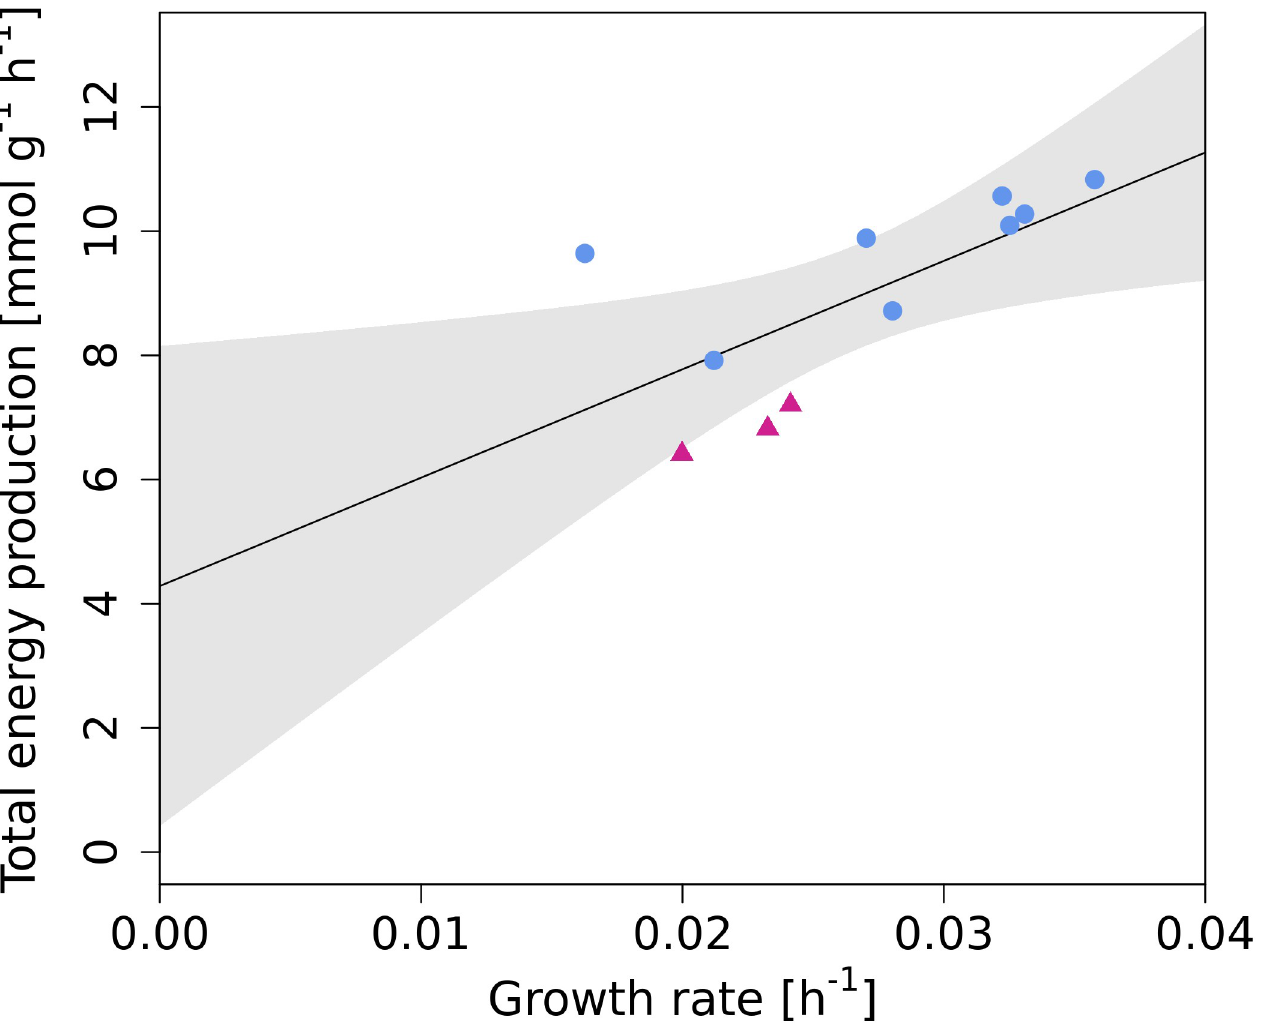
Fig 6. Total energy production at different growth rates (as indicated in Table 1). The black line is a linear fit and the intercept represents energy consumption at zero growth rate. The magenta triangles are dilution rates that had unusually high cell concentration in steady state (see S7 Fig). The shaded area represents 95% confidence